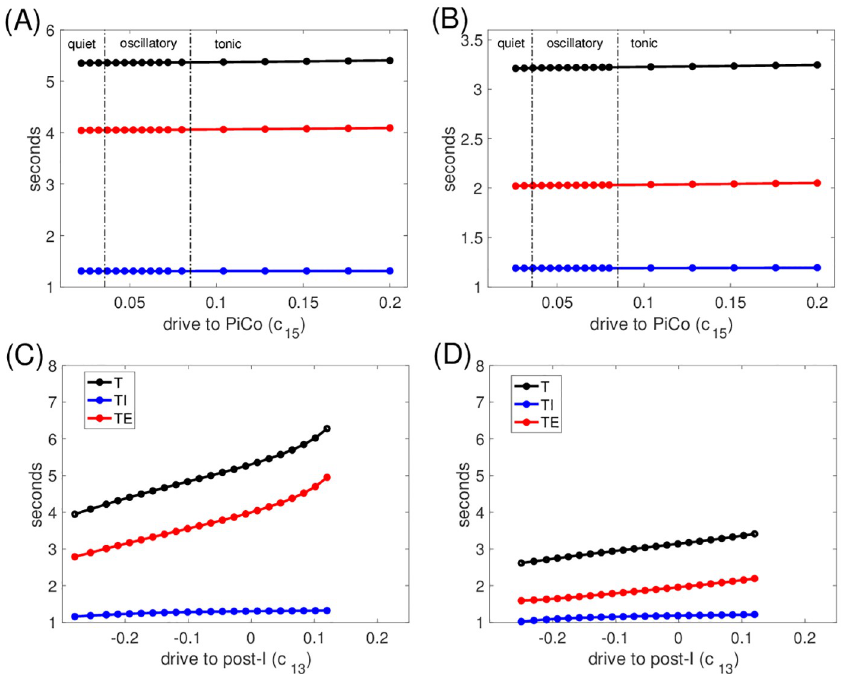
Fig 13. Period is insensitive to drive to the PiCo and to the presence of PiCo. Period T (black), expiratory duration T E (red), and inspiratory duration T I (blue) versus (A,B) PiCo drive parameter ( c 15 ) or (C,D) drive to the post-I unit ( c 13 ), relative to its baseline value of 0.58 (denoted by 0 here). In (A,B), dashed-dotted vertical black lines separate intervals of c 15 values corresponding to different types of PiCo intrinsic dynamics. In (A,C), pre-I is intrinsically oscillatory ( c 11 = − 0.03); in (B,D), pre-I is intrinsically tonic ( c 11 = 0.01). Axis ranges in (C,D) are identical to those in Fig 9 (middle row) except for extension to more negative relative values of c 13 here, since rhythmicity persists down to these lower levels.